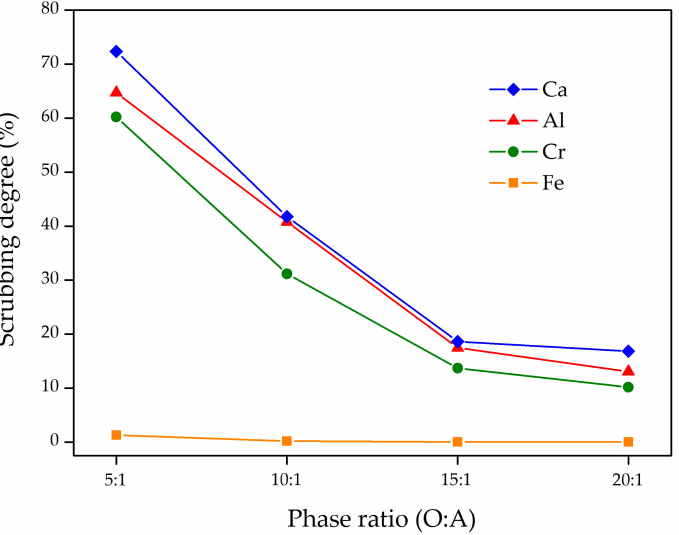
Figure 10. Scrubbing of the iron(III) extract from Al, Ca, and Cr(III) at different O:A ratios by 7 M HCl at C(Fe)org. = 14.68 g/L, C(Al)org. = 0.35 g/L, C(Ca)org. = 0.04 g/L, and C(Cr(III))org. = 0.06